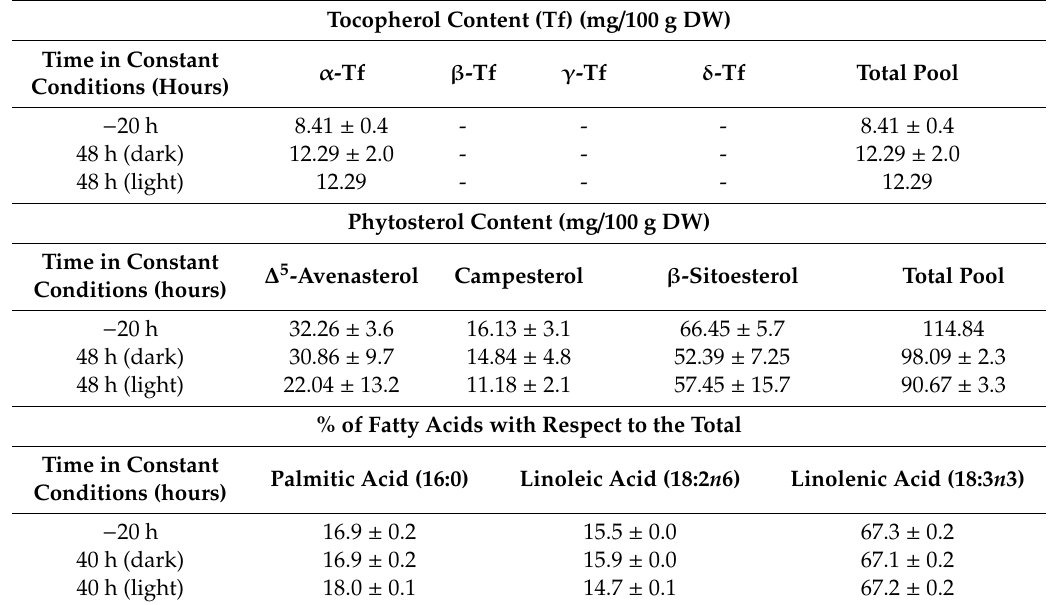
Figure 1. Visual and physiological characterization of rocket. The visual and physiological characterizations were performed by visual quality ( a ) and photochemical e ffi ciency ( b ; Fv / Fm) measurements performed at three di ff erent stages of the experiment: at − 20 h (beginning of the entrainment phase), 0 h (beginning of the continuous phase) and 48 h in continuous illumination conditions of darkness (blue) and light (yellow). Di ff erent lowercase letters indicate significant di ff erence after Tukey’s test ( p = 0.05). Values are the mean of 10 to 16 replicates ± S.E. Positive correlation between visual quality and photochemical e ffi ciency (Fv / Fm) (panel c ) throughout the experiment and the continuous phase (yellow, light conditions and blue, dark conditions). Linear correlations are shown when significant at p < 0.05 (*** p < 0.0001; n.s., not significant). Table 1. Tocopherol (Tf) (mg / 100 g DW) and phytosterol (mg / 100 g DW) contents and the percentage of fatty acids with respect to the total fatty acids at − 20 h and 48 h from the beginning of the continuous phase.